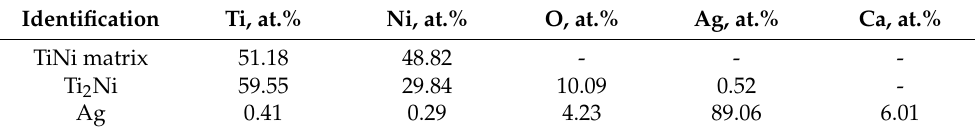
Figure 6. SEM image and EDS elemental mapping of porous SHS alloy TiNi + 0.5% Ag. Table 3. Elemental composition of phases in SHS alloys TiNi + 0.2% Ag. Identification Table 3. Elemental composition of phases in SHS alloys TiNi + 0.2% Ag.